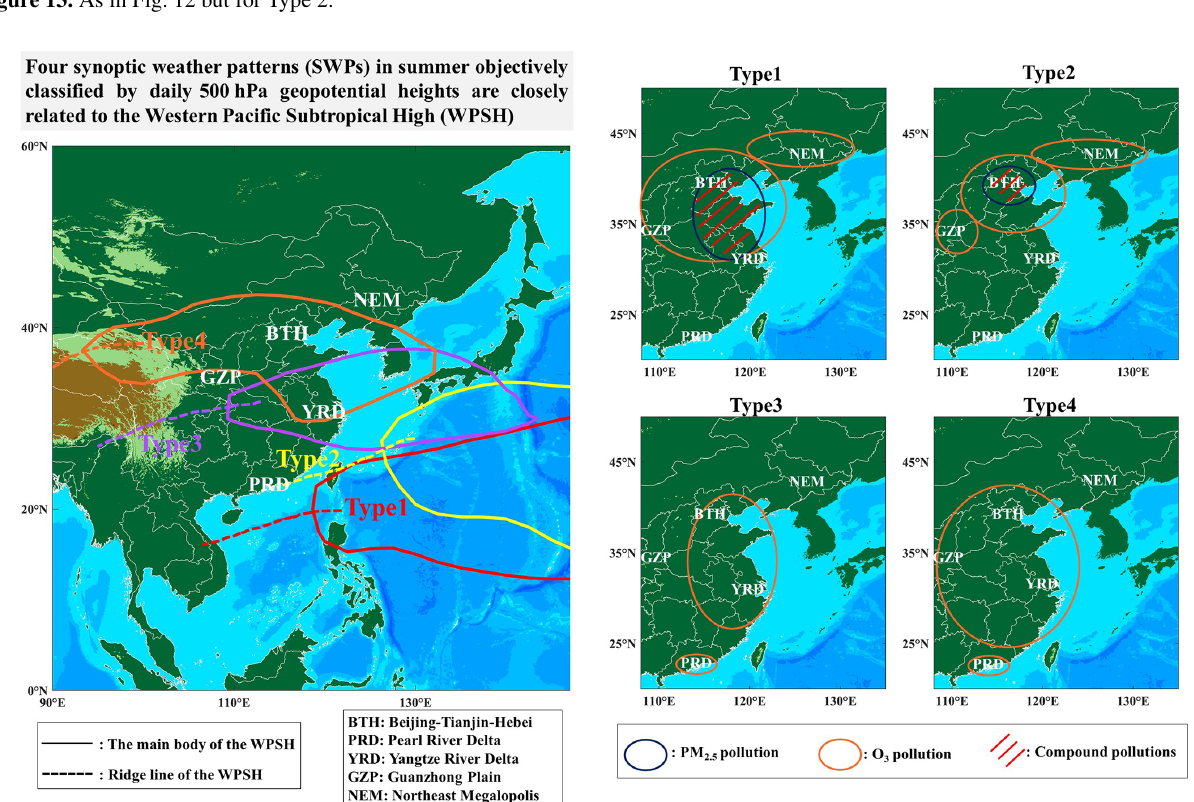
Figure 14. Schematic diagrams describing the relationships between the WPSH, four SWPs and summertime O 3 and PM 2 . 5 pollution in various